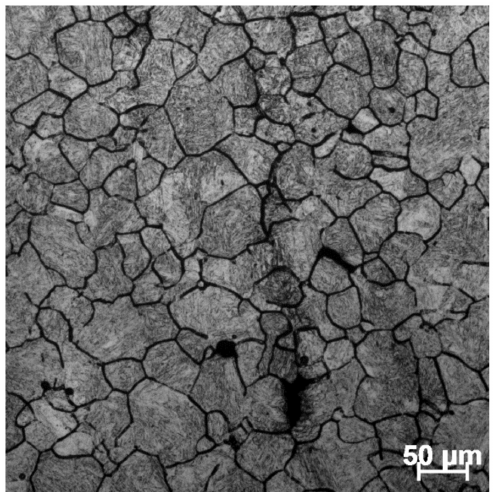
Figure 22. Optical microstructures of SAE 5137H steel corresponding to the speed-loading path at 1483